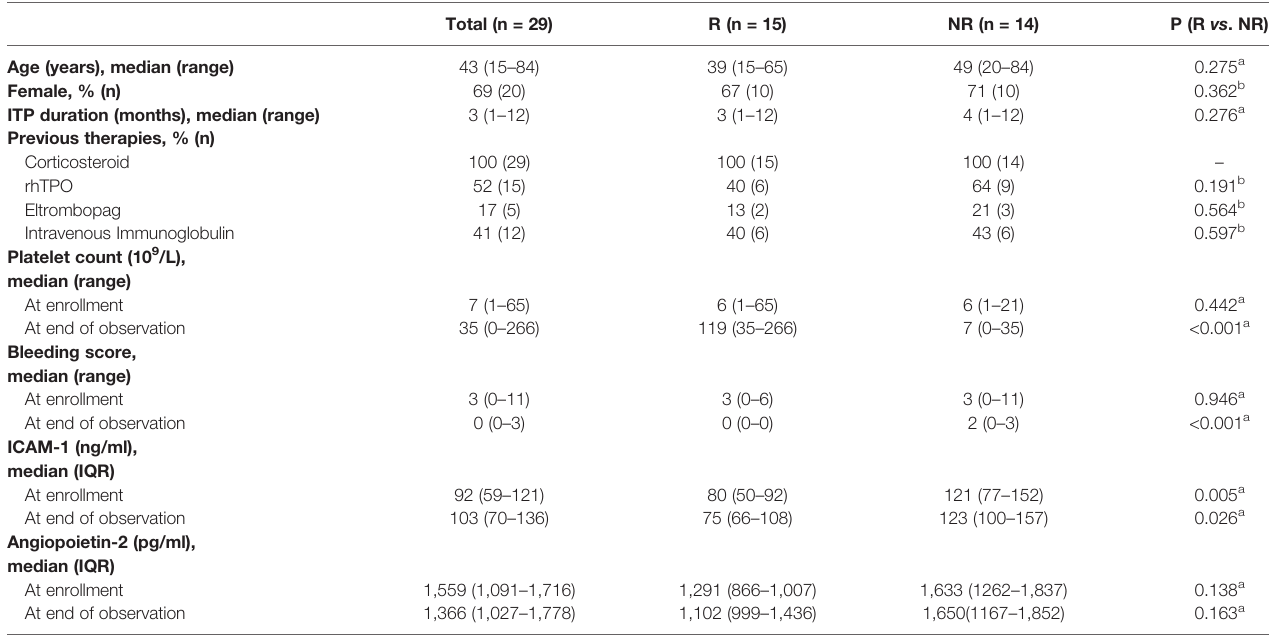
TABLE 3 | Personal and laboratory characteristics of 29 corticosteroid resistant ITP patients who received consecutive low-dose decitabine